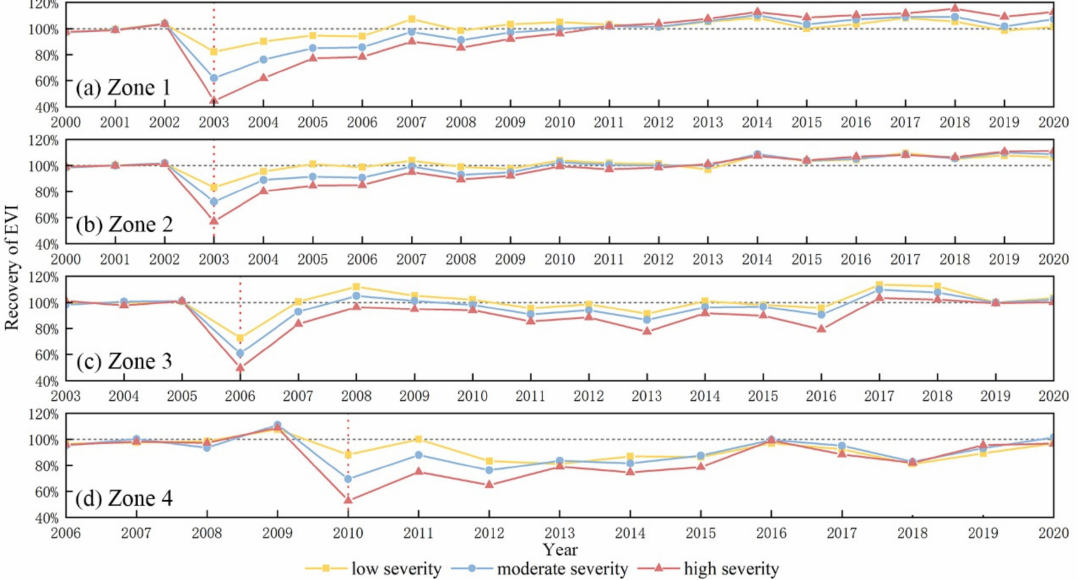
Figure 6. Recovery of EVI for different fire severities levels where ( a – d ) represent Zone 1–4. The red vertical dashed line is the fire year, and the gray horizontal dashed line is the reference line for the average EVI values for the three years before the